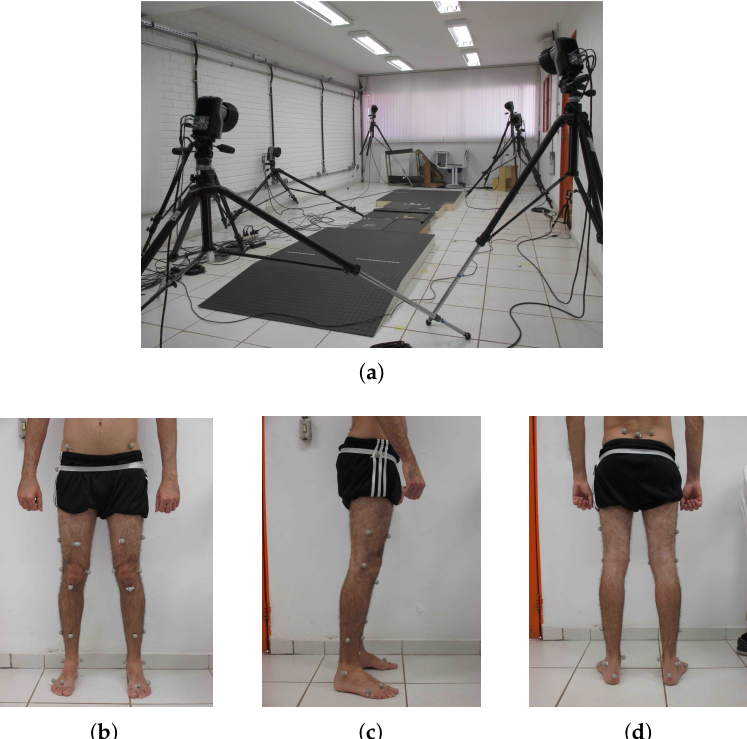
Figure 1. The experimental setup: ( a ) the walkway with three force platforms and eight cameras of the motion capture system around it. The marker set used on the subjects: ( b ) frontal, ( c ) lateral, and ( d ) posterior